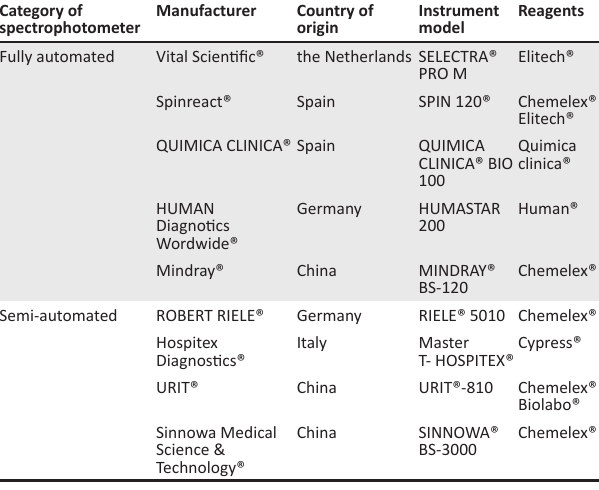
TABLE 2: Spectrophotometers and brands of analysers and reagents used by the participating laboratories in Togo from July 2016 to December 2016 . Category of spectrophotometer